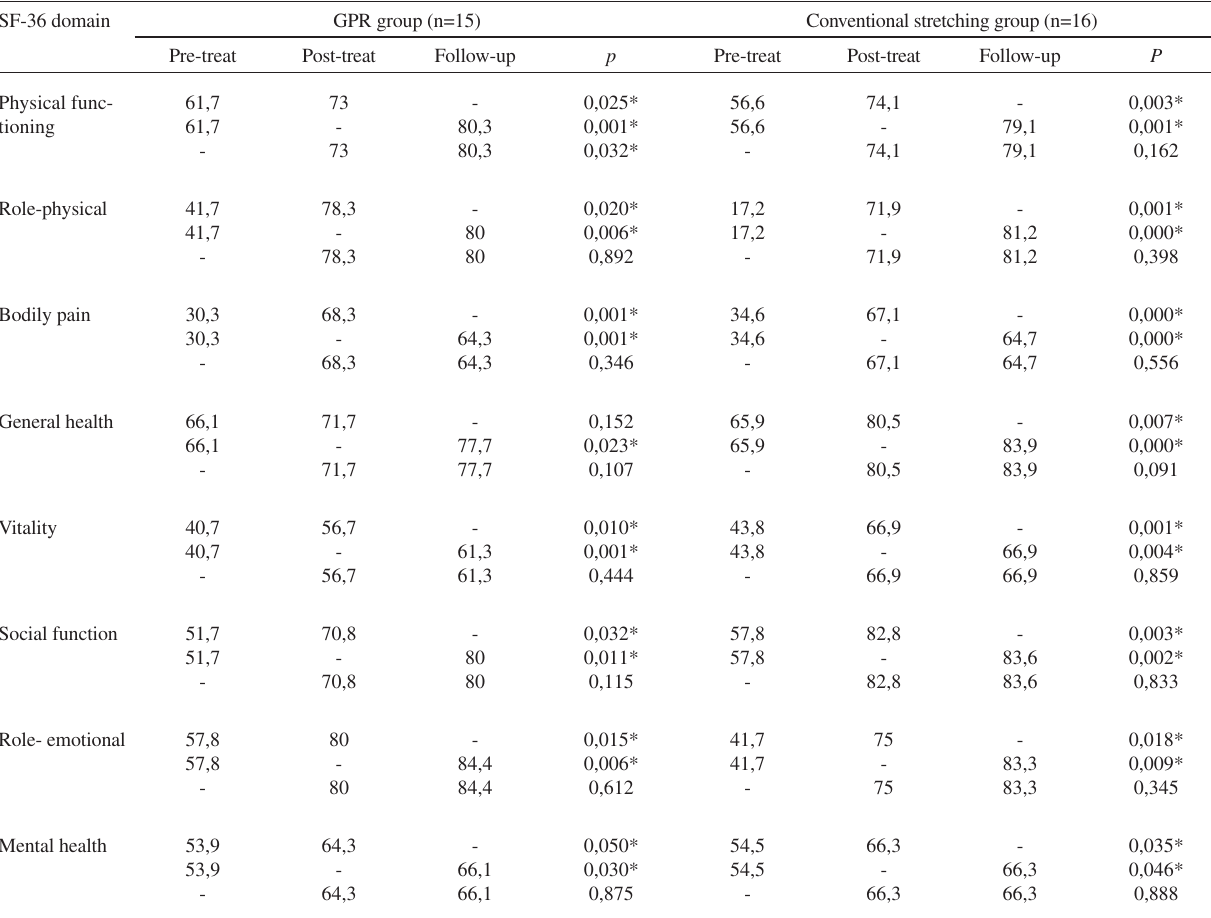
Table 3 - SF-36 mean scores of both groups at pre- and post-treatment evaluations and at follow-up, and p values for the com- parisons pre X post , pre X follow-up, and post X